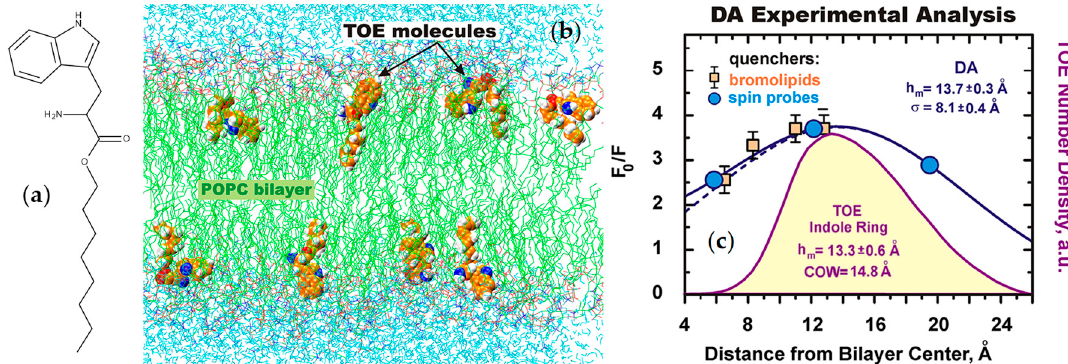
Figure 7. ( a ) Structure of tryptophan octyl ester (TOE). ( b ) Snapshot of an 8 TOE:288 POPC bilayer. ( c ) Comparison of experimental quenching ratios (data from bromolipid quenchers was scaled by a factor of 1.5 for visual comparison) and distribution analysis (DA) model parameters with TOE indole ring distribution obtained from MD simulation. h m : Gaussian fit center of quenching profile (experimental) or most probable location (MD distribution); σ : Gaussian fit standard deviation; COW: center-of-weight of the depth distribution. Adapted with permission from [105]. Copyright 2013 American Chemical Society.